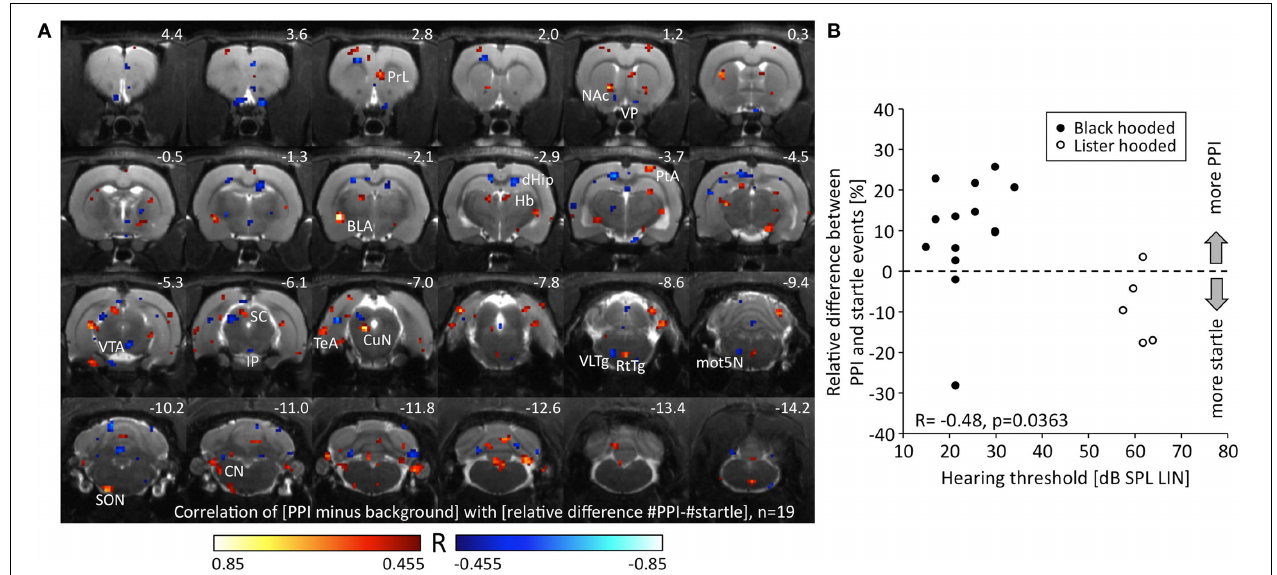
FIGURE 4 | Relationship between metabolic activity and PPI/startle. (A) R-map resulting from a Pearson correlation test linking the change of metabolic activity during PPI-PET vs. background with the relative difference between PPI and startle events. Red colored voxels depict positive correlation, i.e., the more PPI events, the higher the metabolic activity. Blue color indicates voxels with negative correlation, i.e., the more startle events, the higher the metabolic activity. Only voxels with a significant R -value are shown ( p < 0 . 05, uncorrected). (B) The relative difference between PPI and startle events was negatively correlated to hearing threshold. The better the hearing capacity the higher was the relative number of PPI events. Note that